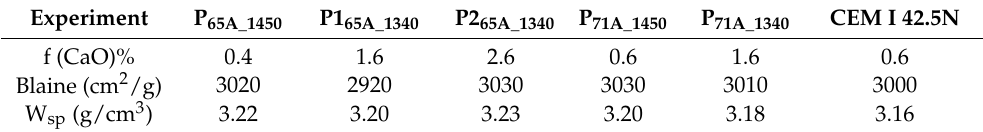
Table 4. Free lime (f(CaO)), fineness (Blaine) and specific weight (W sp ) of the studied clinkers.